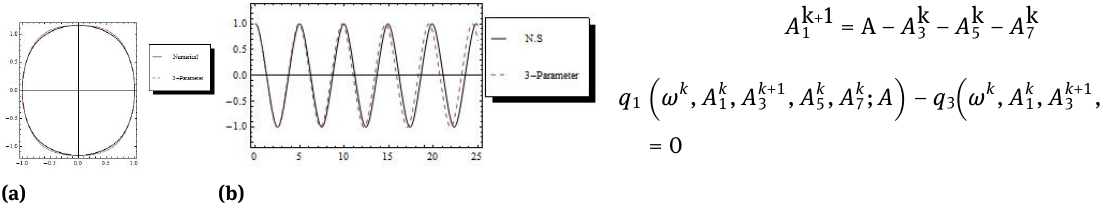
Fig. 1. (a) Comparison for the u versus ˙ u trajectory for the case of A = 1 (b) t versus u (displacement A = 1